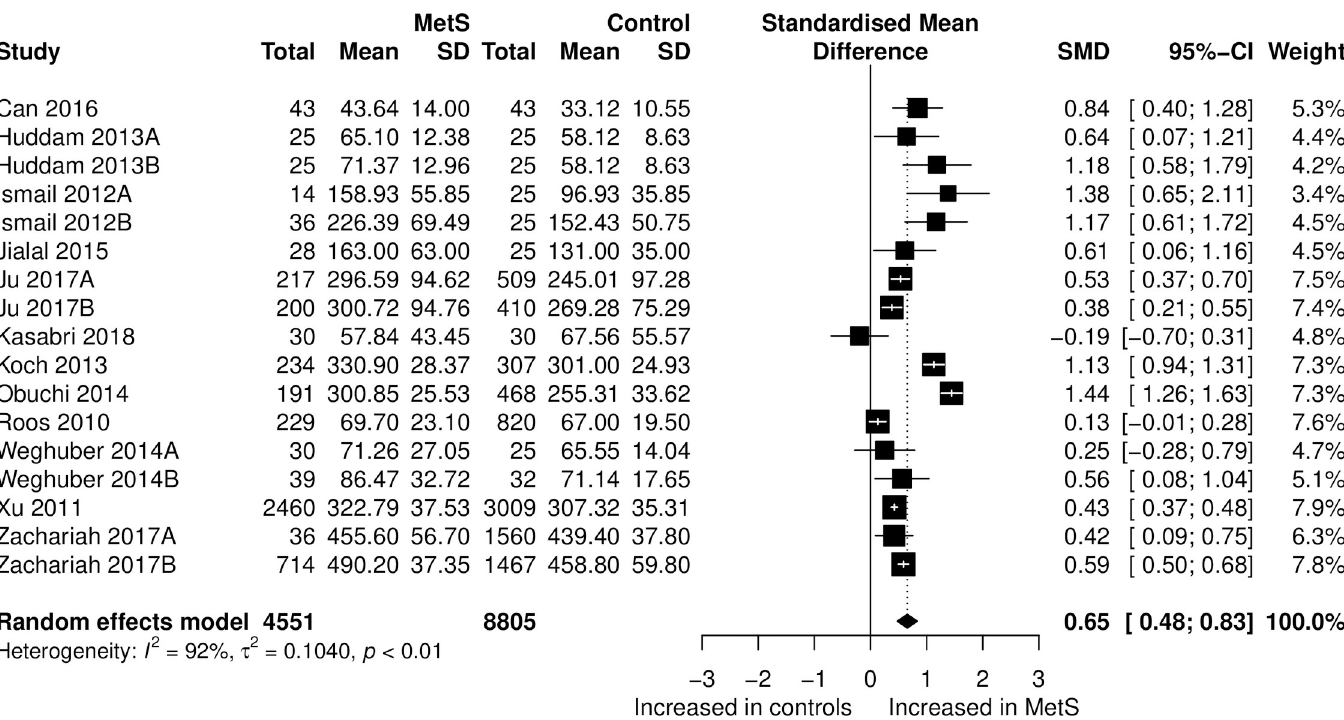
Fig 3. Forest plot of fetuin-A between MetS participants and controls. Study effect sizes of fetuin-A concentration differences between MetS and controls. Each data marker represents a study, and the size of the data marker is proportional to the total number of individuals in that study. The summary effect size for each fetuin-A concentration is denoted by a diamond. MetS, Metabolic syndrome; SMD, standardized mean